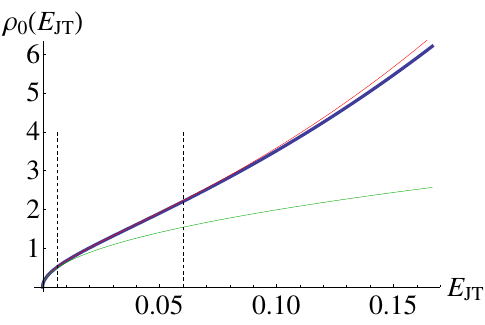
Figure 4 . (Blue) Energy density of states ρ 0 ( E JT ) defined in (3.22) with b = 1 / 2 . (Red) JT limit which focusses on the middle region. (Green) spectral edge